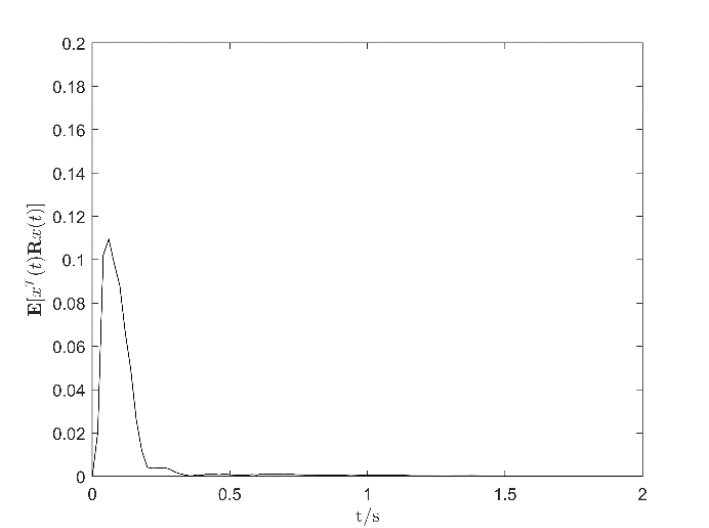
Figure 3. The evolution of E [ x T ( t ) Rx ( t )] for system